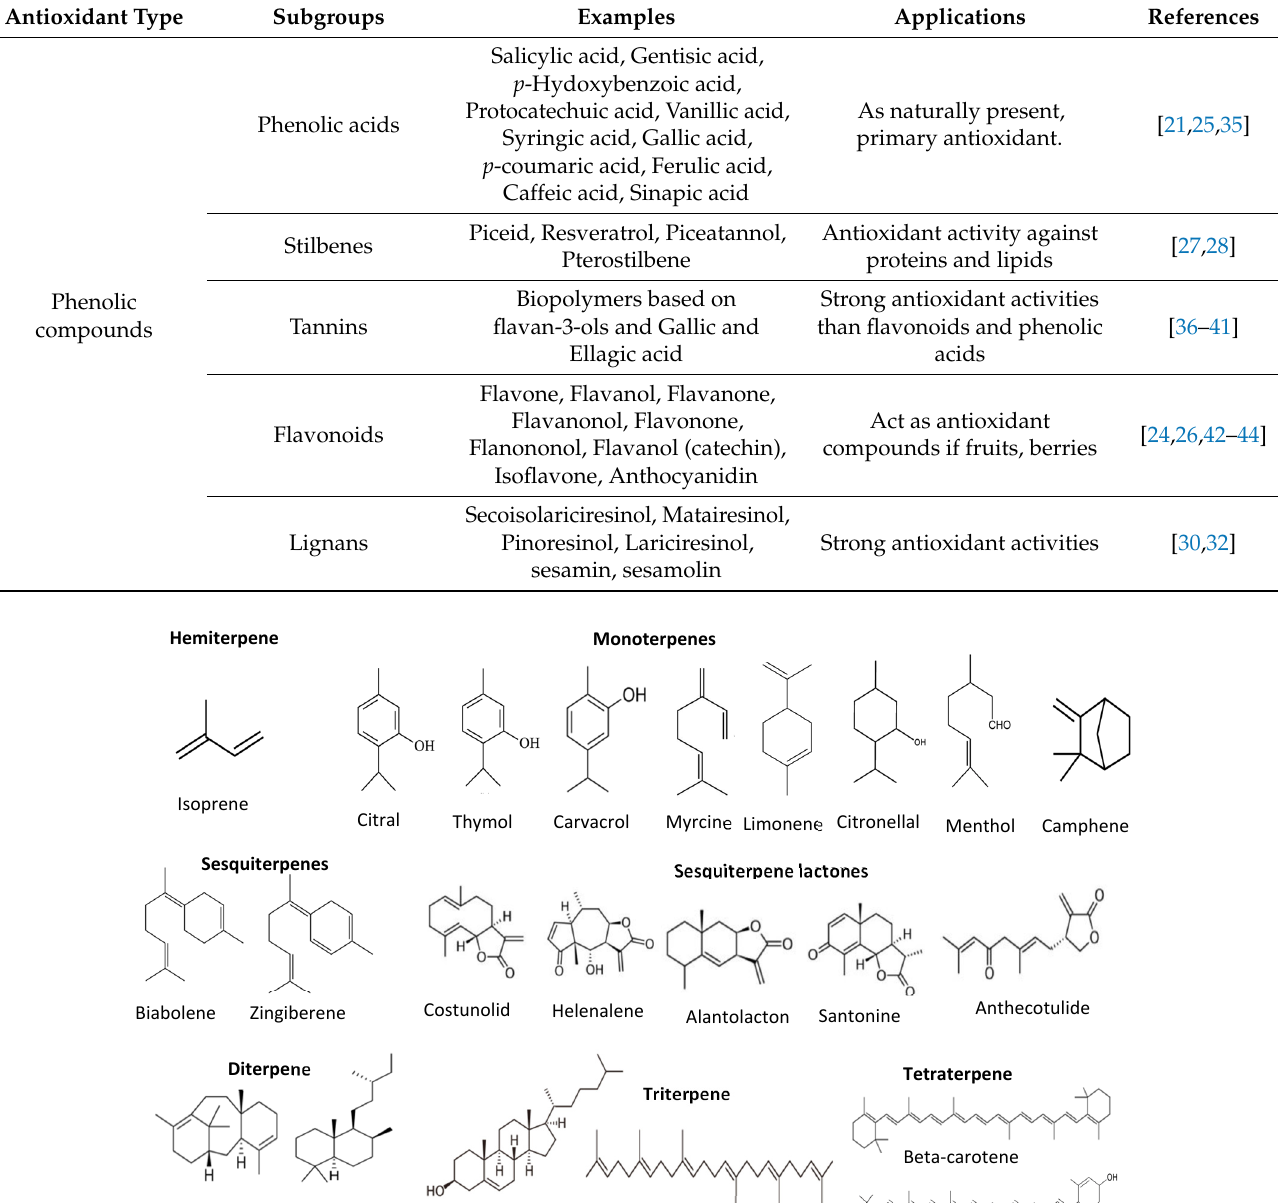
Table 1. Most common plant-based phenolic antioxidants and their potential applications.